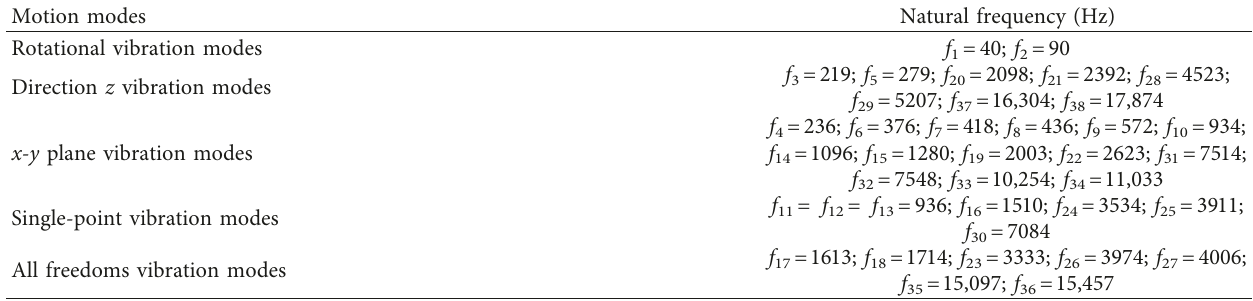
Table 4: Natural frequencies and vibration